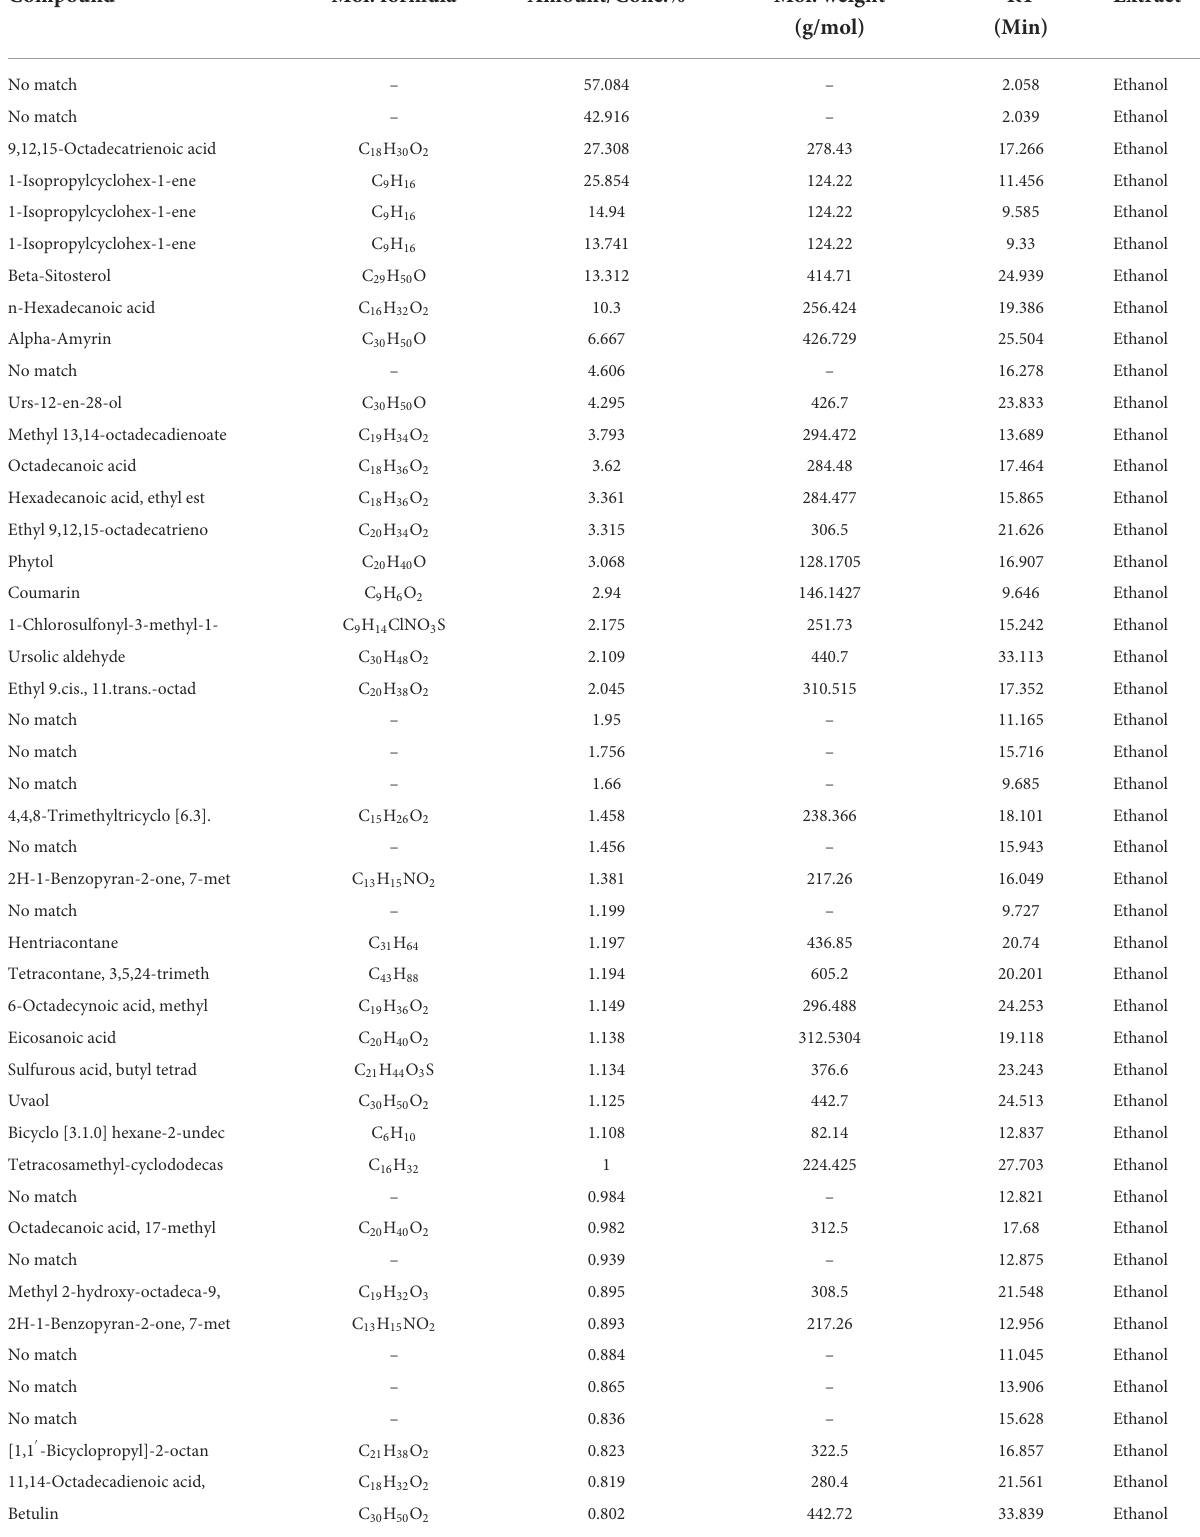
TABLE 3 GC/MS analysis of ethanol extract of N. cataria using NIST 17 Library showed (79 identified phytochemicals + 31 unmatched) chemicals, arranged according to concentration present. Compound Mol. formula Amount/Conc.%